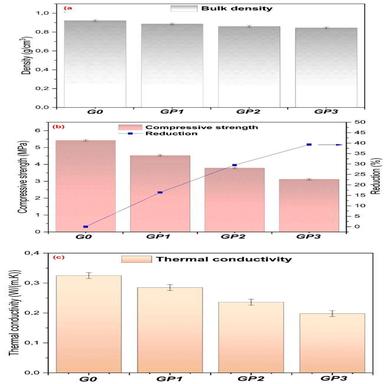
(a) The bulk density, (b) Compressive strength and (c) Thermal conductivity of Gypsum/PCM composites.